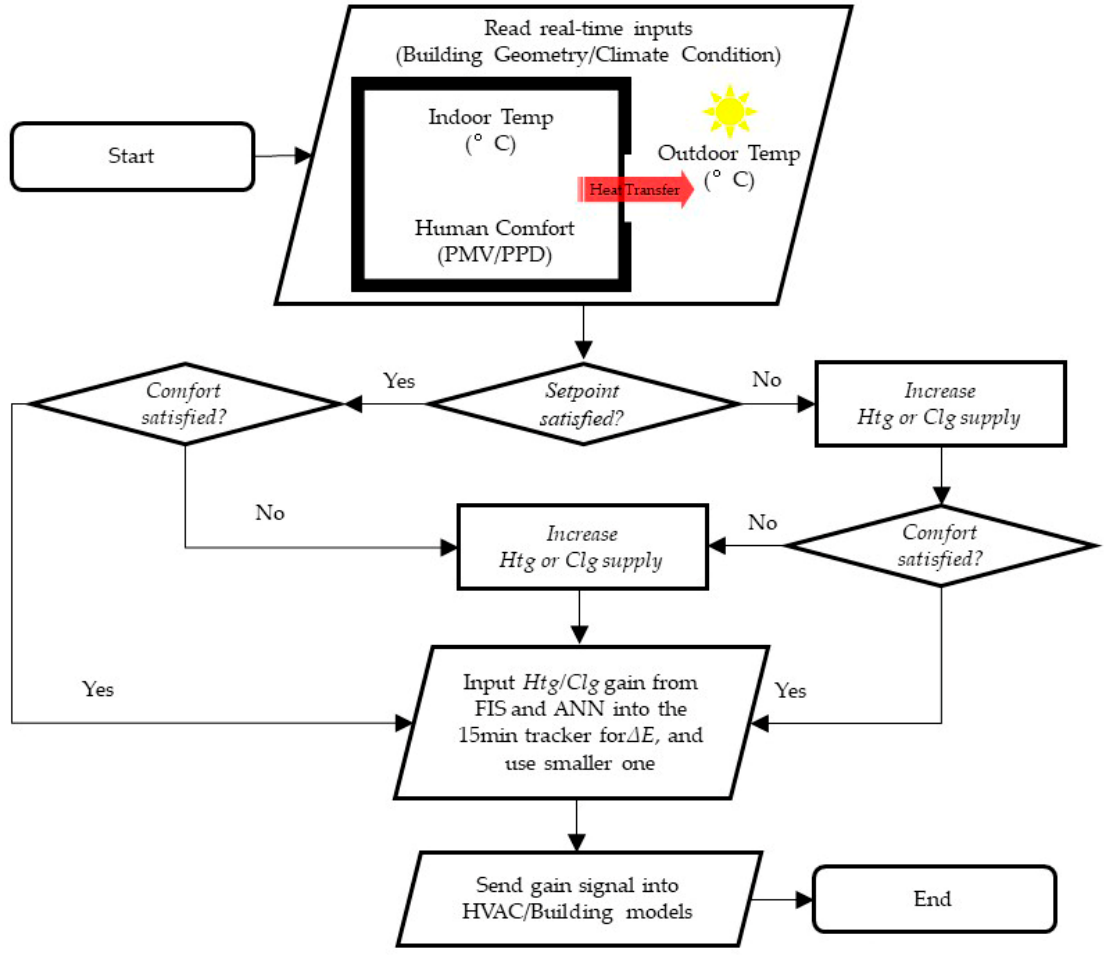
Figure 1. Simulation framework.